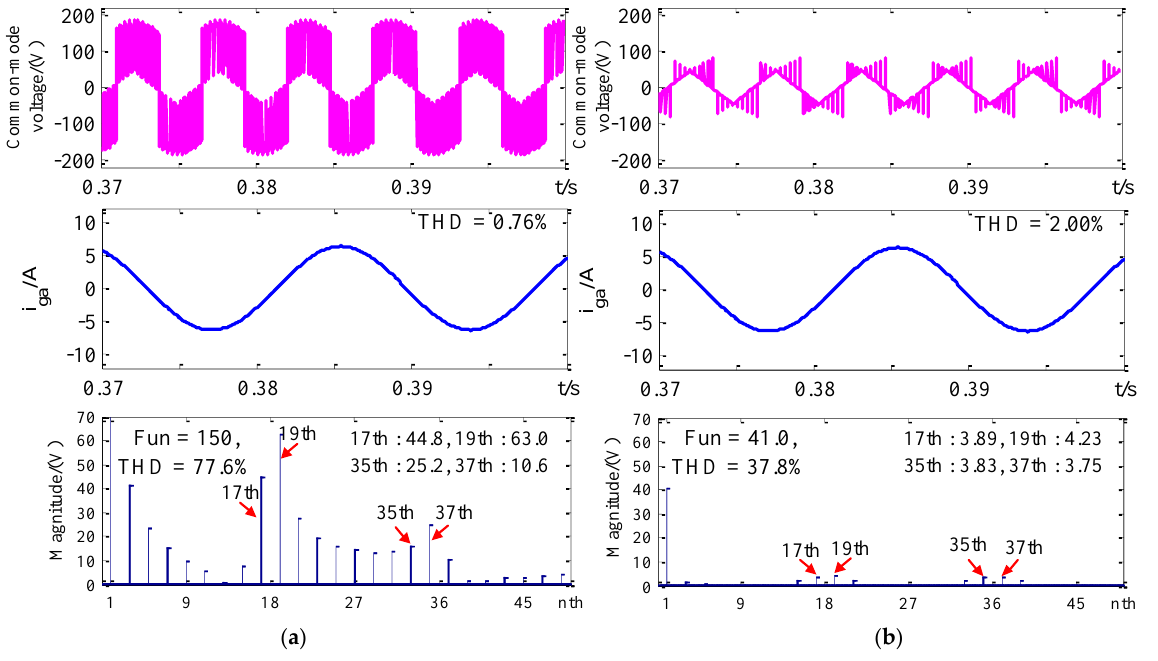
Figure 9. CMV and 𝑖 𝑔𝑎 ( 𝑚 𝑎 = 0.417): ( a ) SVM1 and ( b ) SVM2. Figure 9. CMV and i ga ( m a = 0.417): ( a ) SVM1 and ( b ) SVM2. Figure 9 shows the output performance with 𝑚 𝑎 equal to 0.417. Due to the Figure 9 shows the output performance with m a equal to 0.417. Due to the rearrange- rearrangement in the space vector sequence, SVM2 generates higher THD in the grid ment in the space vector sequence, SVM2 generates higher THD in the grid current, but current, but the grid current’s magnitude is relatively low due to the applied small 𝑚 𝑎 , the grid current’s magnitude is relatively low due to the applied small m a , which implies which implies the impacts of harmonic components on grid currents are not severe. In the impacts of harmonic components on grid currents are not severe. In terms of the HF-CMVs, SVM2 is better than SVM1. With SVM2, the magnitudes of the 17th and 19th order harmonics in the CMV can be reduced from 44.8 V and 63.0 V to only 3.89 V and 4.23 V, respectively. Moreover, the magnitudes of the 35th and 37th order harmonics are suppressed from 25.2 V and 10.6 V to only 3.83 V and 3.75 V, respectively. With lower HF-CMVs, the leakage current in a transformerless grid-connected CSI can potentially be suppressed. → I w aligns with that of The results in Figures 8 and 9 are obtained when the angle of → m a of 0.8333, there is no noticeable difference in terms of the grid current’s THD by SVM1 → → I w lags v Cf by 30 ◦ , the 17th, 19th, and and SVM2, as shown in Figures 10 and 11. When 37th order CMV harmonics are reduced from 45.3 V, 51.0 V, and 16.1 V to 14.3 V, 12.3 V, and 10.3 V, respectively by SVM2, as shown in Figure 10. An increment from 6.68 V to → → I w leads v Cf by 30 ◦ . With SVM2, the 17th 14.6 V appears at the 35th order. In Figure 11, and 19th order CMV harmonics are mitigated from 12.7 V and 15.4 V to 10.7 V and 13.3 V, respectively. Furthermore, the 35th and 37th order CMV harmonics are reduced from 31.9 V and 37.1 V to 10.3 V and 8.14 V, respectively. The results verify the effectiveness of SVM2 in mitigating high-frequency harmonics under various phase angle differences with respect to the filter capacitor